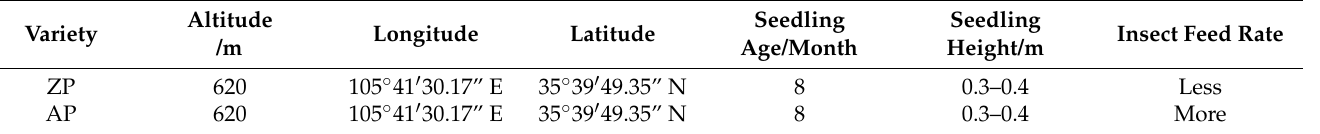
Table 2. Basic situation of the seedling